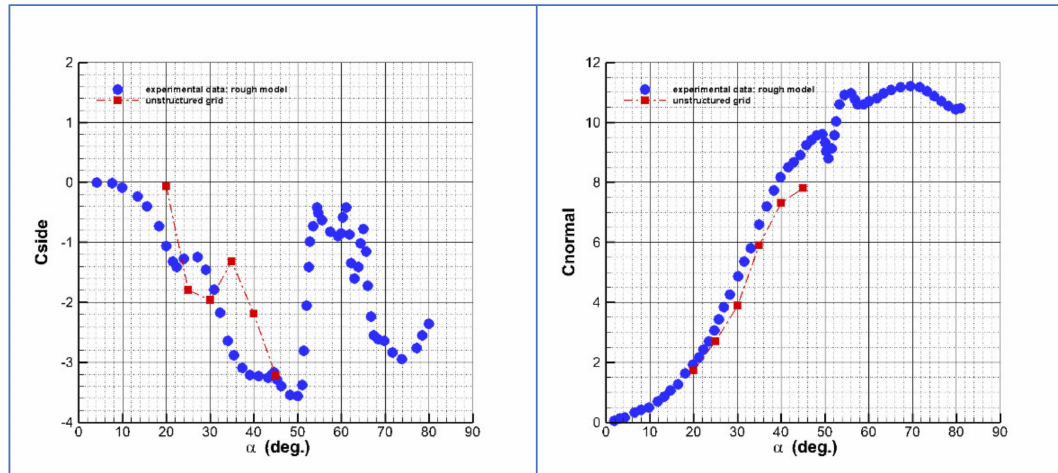
Figure 13. ( Left ) side force coefficient versus angle of attack. ( Right ) normal force coefficient versus angle of attack. Ma = 0.2, Re = 2 × 10 6 . Grid U1 solutions (red squares) compared to experimental data (in blue dots) for the rough